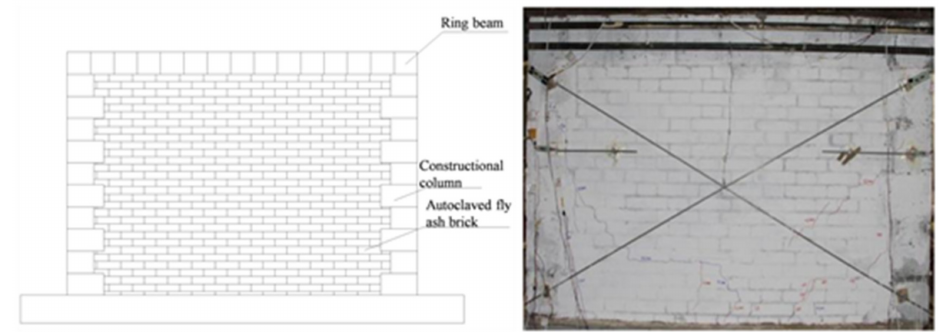
Figure 9. Reinforced masonry